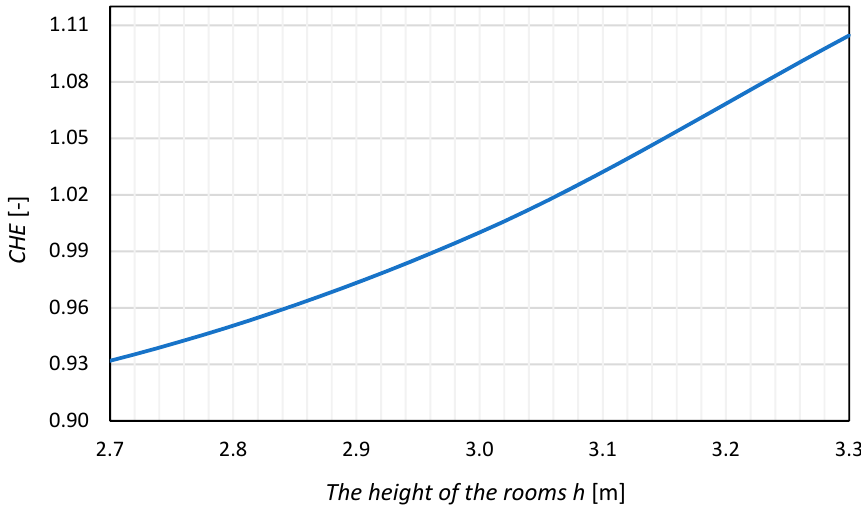
Figure 12. Influence of the height of a modular house on the final energy demand.